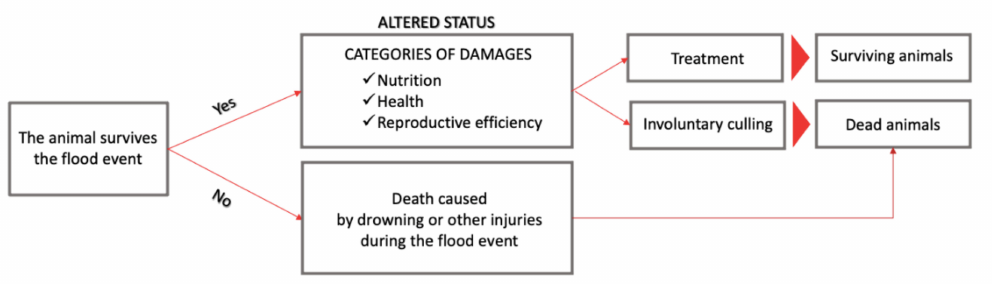
Figure 4. Categorization of